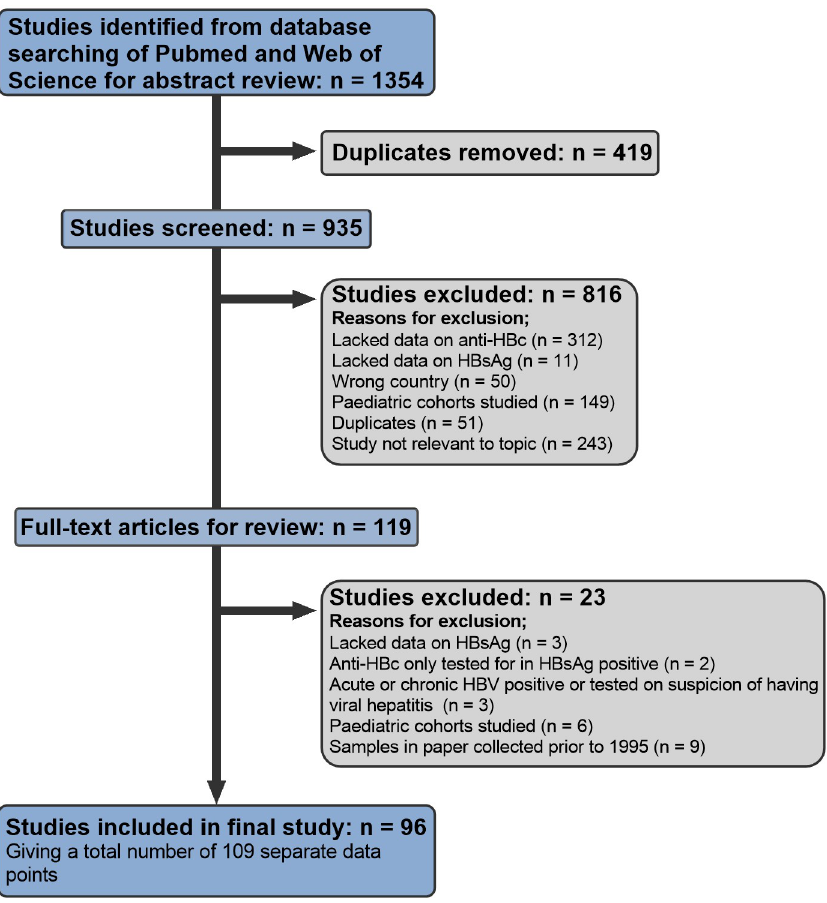
Fig 1. PRISMA flowchart showing selection of studies of HBsAg and anti-HBc prevalence in Africa, published 1995–2019, for inclusion in meta-analysis. The analysis included 96 studies; 13 of these studies reported data for 2 discrete cohorts, giving a total of 109 data points included in the final analysis. Anti-HBc, antibody to hepatitis B core antigen; HBsAg, hepatitis B surface antigen; HBV, hepatitis B virus; PRISMA, Preferred Reporting Items for Systematic Reviews and